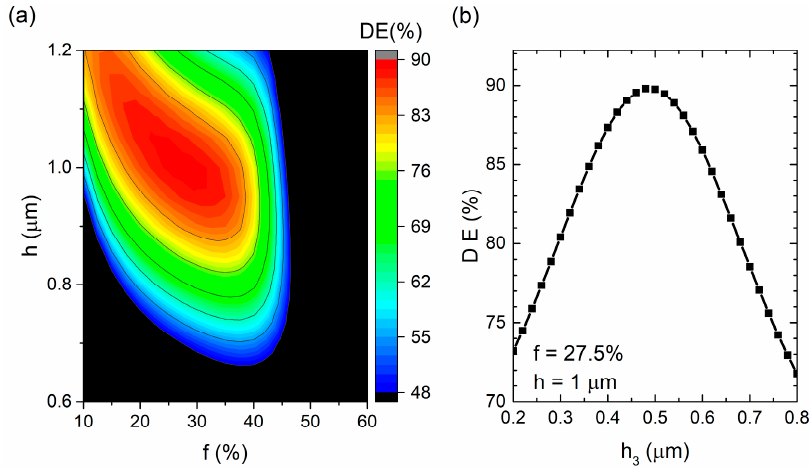
Figure A1. ( a ) Calculated GaAs diffraction efficiency (DE) as a function of groove depth ℎ and fill ‐ ing factor 𝑓 , with h 1 = 530 nm ‐ thick SiO 2 ARC and ( b ) diffraction efficiency versus SiO 2 ARC thick ‐ ness (cid:4666)ℎ (cid:2869) (cid:4667) , at 𝜆 (cid:3043) (cid:3404) 3.0 μ m, d (cid:3404) 2.4 μ m, and 3 THz phase ‐ matching frequency. Figure A2a shows a plot of calculated diffraction efficiencies as a function of groove depth h and filling factor f that results from adding a layer of NOA as an ARC in GaAs CG at 3.0 μ m pump wavelength, d (cid:3404) 2.4 μ m grating period, and at 3 THz phase ‐ matching frequency. The maximum diffraction efficiency of 89.6% was achieved with CG at 3.0 µ m pump wavelength, d = 2.4 µ m grating period, and at 3 THz phase-matching optimal filling factor 𝑓 (cid:3404) 27.5 % and optimum groove depth ℎ (cid:3404) 1 μ m . Comparing frequency. The maximum diffraction efficiency of 89.6% was achieved with optimal filling Figure 6a (without ARC) with Figure A2a, a 30% relative increase in diffraction efficien ‐ factor f = 27.5% and optimum groove depth h = 1 µ m. Comparing Figure 6a (without cy can be achieved. ARC) with Figure A2a, a 30% relative increase in diffraction efficiency can be achieved.